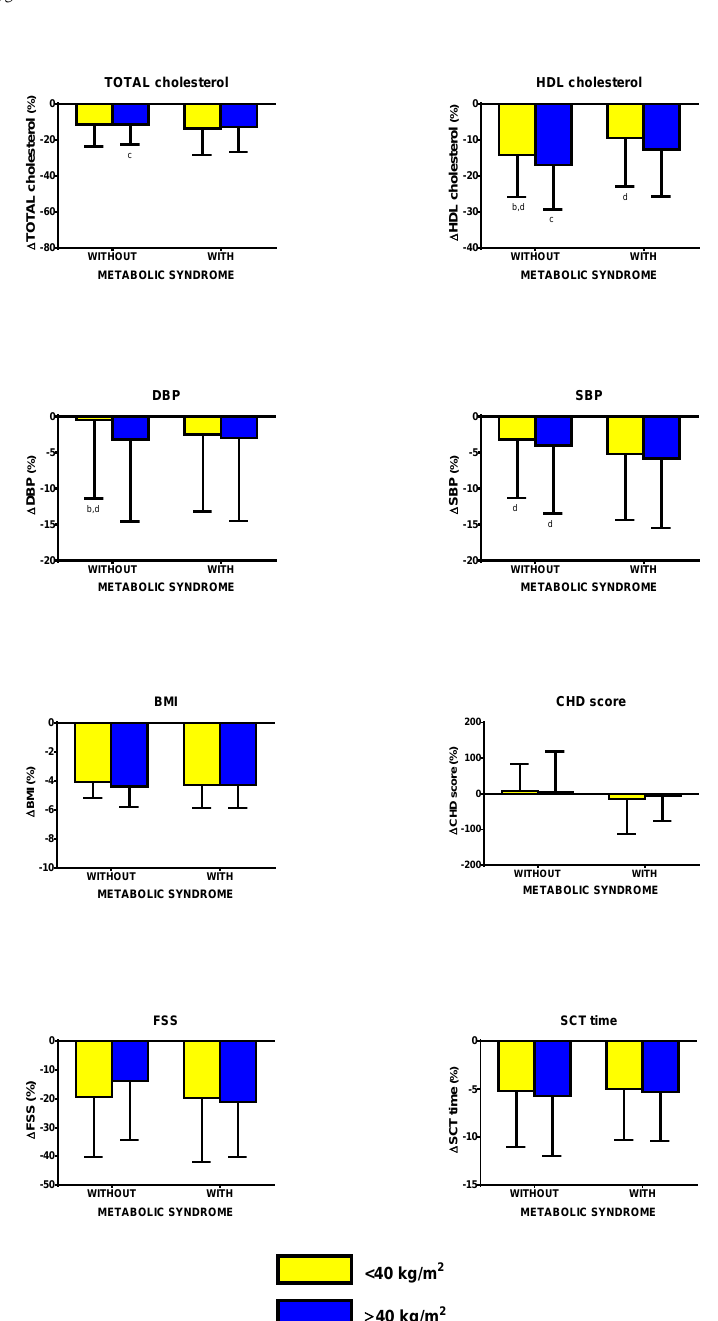
Figure 2. Changes of total cholesterol, HDL cholesterol, diastolic blood pressure (DBP), systolic blood pressure (SBP), body mass index (BMI), coronary heart disease (CHD) score, fatigue severity score (FSS), and stair climbing test (SCT) time, before and after a three-week body weight reduction program (BWRP) in obese subjects with or without metabolic syndrome, subdivided for BMI (<40 kg/m 2 or obese subjects of degree 1–2 and ≥40 kg/m 2 or obese subjects of degree 3). Data are expressed as mean ± SD. All parameters were compared among all subgroups (</≥40 kg/m 2 and with/without metabolic syndrome) by using a two-way ANOVA, followed by post hoc Bonferroni’s test. b : 0.05 vs <40 kg/m 2 obese subjects without metabolic syndrome; c : p < 0.05 vs. ≥40 kg/m 2 obese subjects with metabolic syndrome; d : p < 0.05 vs. ≥40 kg/m 2 obese subjects with metabolic syndrome. In order to facilitate the interpretation of multiple comparisons, please, note that the four boxes (1, 2, 3, and 4) of each panel may be named as “a”, “b”, “c”, and “d” from the left side to the right one. Therefore, when the symbol of significance is indicated under a box (e.g., “c” under Box 2), this means that the comparison between the two boxes (i.e., Boxes 2 and 3) is statistically significant.